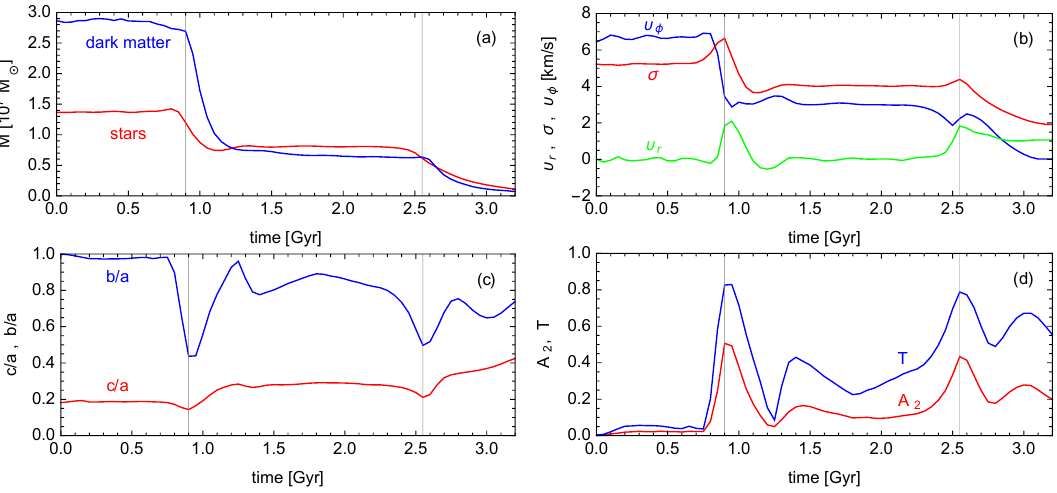
Figure 4. Evolution of the dwarf’s properties in time. In each panel, the vertical gray lines indicate pericenter passages. All measurements were performed for particles within the radius of 1 kpc from the center of the dwarf. ( a ) The mass of the dark matter (blue) and stars (red); ( b ) Kinematic properties of the dwarf: the rotational velocity v φ (blue), the 1D velocity dispersion σ (red) and the mean radial velocity v r (green); ( c ) The axis ratios b / a (blue) and c / a (red); ( d ) The triaxiality parameter T (blue) and the bar mode A 2